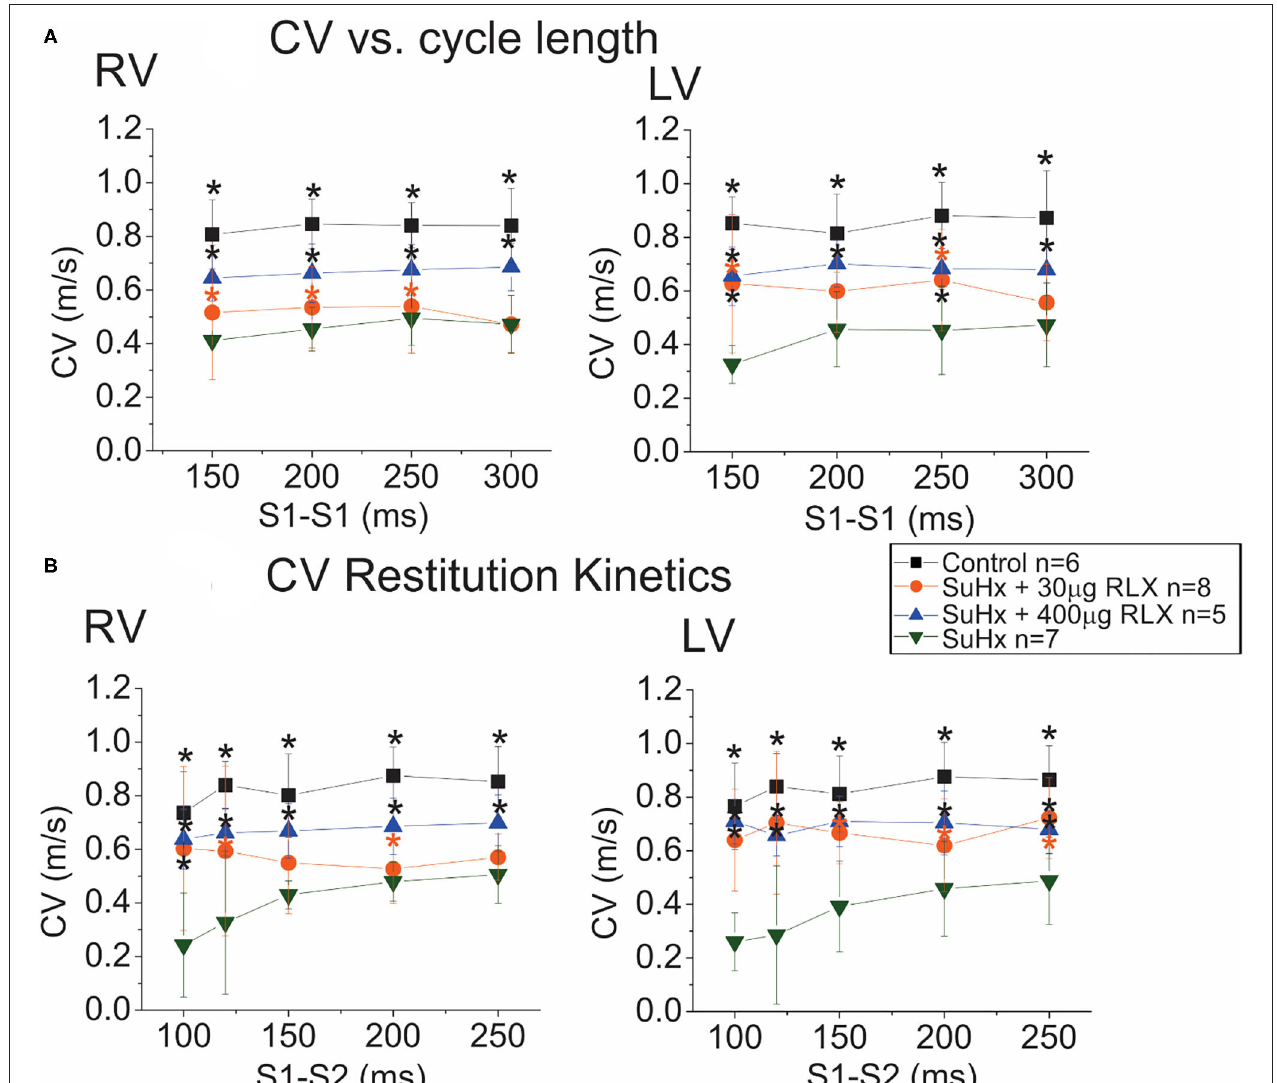
FIGURE 4 | Effects of RLX on CV and Restitution Kinetics (RK). (A) : Plots of CV vs. cycle length show a 50% decrease in CV in the RV (left) and LV (right) of SuHx hearts compared to controls. RLX treatments partially prevented CV slowing in a dose-dependent manner. (B) : RK plots the CV of the premature AP as a function of S1-S2 inter-pulse interval. CV RK curves of SuHx hearts have a steeper slope and are reduced compared to controls in the RV and LV, and RLX reduces the slope of CV RK curves and increases CVs in a dose-dependent manner. *Indicates p < 0.05 vs.